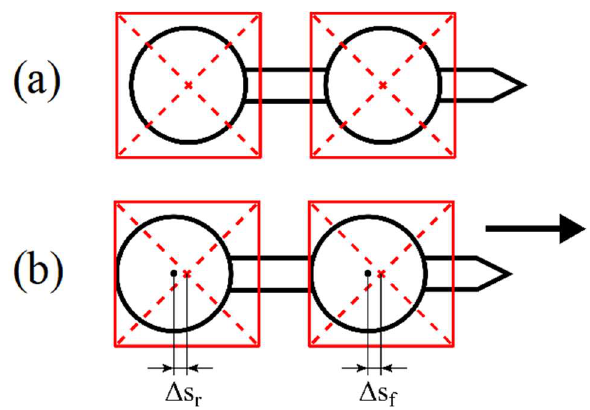
Figure 5. Trapped bead displacement with respect to the trapping laser beams. For a stationary tool ( a ), the trap centers (red squares) overlap with the centers of the beads. When the traps move and pull the tool ( b ), the displacements between the trapping beams and the beads centers Δs f and Δs r may be used to measure the drag forces. Further in the paper ‘Δs’ is used to denote any displacement since it is clear from the context whether it refers to the front or rear bead.